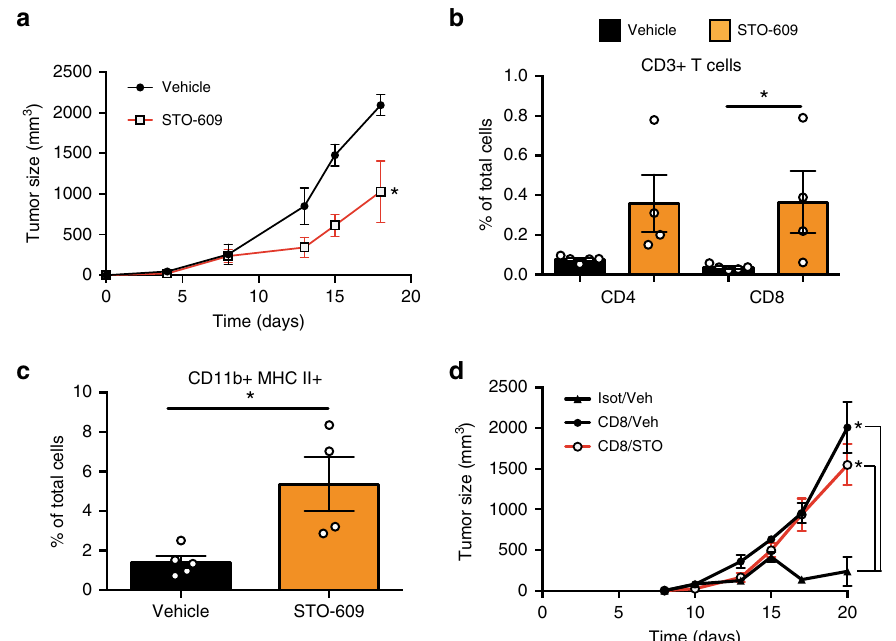
Fig. 8 Pharmacological inhibition of CaMKK2 attenuates mammary tumor growth in immunocompetent mice. a E0771 (4×10 5 ) cells were orthotopically grafted into syngeneic WT mice. Starting at day 2 after grafting, mice were treated three times/week with vehicle or STO-609 (IP, 100 μ moles/kg body weight), and subsequently tumor volumes measured (mean±SEM; N = 6 in each group); two-way ANOVA was used to calculate p -values. b , c T lymphocytes and myeloid cells within E0771 mammary tumors treated with STO-609 or vehicle. Tumors of comparable size (500 – 700mm 3 ) were removed, digested and single-cell suspensions were stained for myeloid and lymphoid markers, and analyzed using the gating strategy reported in Supplementary Fig. 3C and 11. Treatment with STO-609 resulted in the accumulation of CD8 + T cells and CD11b + MHC II + myeloid cells (b and c, respectively). Bar graph shows mean± SEM; N = 5 and 4 tumors in Veh and STO-609 groups, respectively. A t test was used to calculate p -values. d STO-609 failed to affect mammary tumor growth in CD8 + T cell-depleted Camkk2 − / − mice. Camkk2 − / − mice were treated with anti-CD8 or control isotype antibodies. Subsequently, E0771 cells were orthotopically grafted, and mice treated with STO-609 or vehicle. Tumor volumes were measured (mean±SEM; N = 3, 7, and 8 in isotype/Veh, CD8/Veh and CD8/STO groups, respectively). Two-way ANOVA test was used to calculate p -values. Asterisks refer to * p